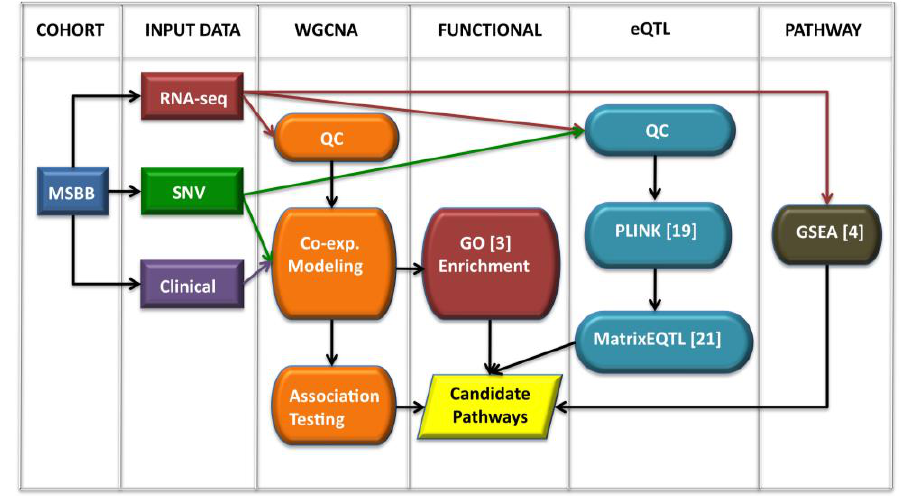
Figure 1. High-level diagram of our integrative analysis workflow: RNA-seq dataset (red) was combined with clinical data (purple) for co-expression modeling and association testing, whereas RNA-seq was combined with SNV genotype data (green) for eQTL analysis. GSEA was used to independently validate candidate pathways.